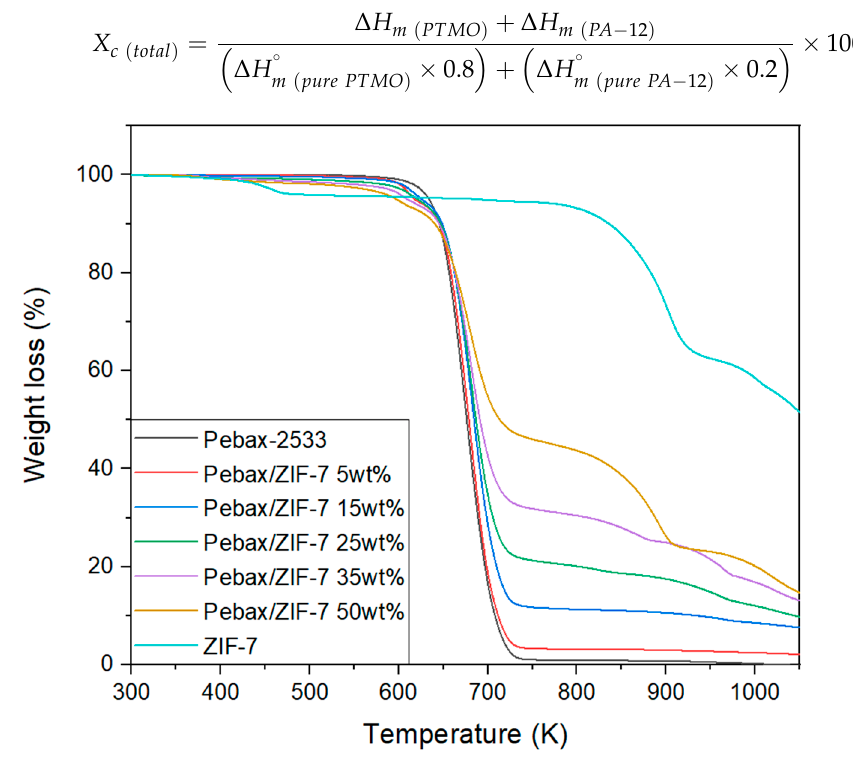
Figure 7. TGA thermograms of Pebax ‐ 2533/ZIF ‐ 7 composite membranes. Table 2. Melting temperature and melting enthalpy of Pebax-2533/ZIF-7 composite membranes. Using the DSC results of the Pebax ‐ 2533/ZIF ‐ 7 membrane, we identified the changes Membranes